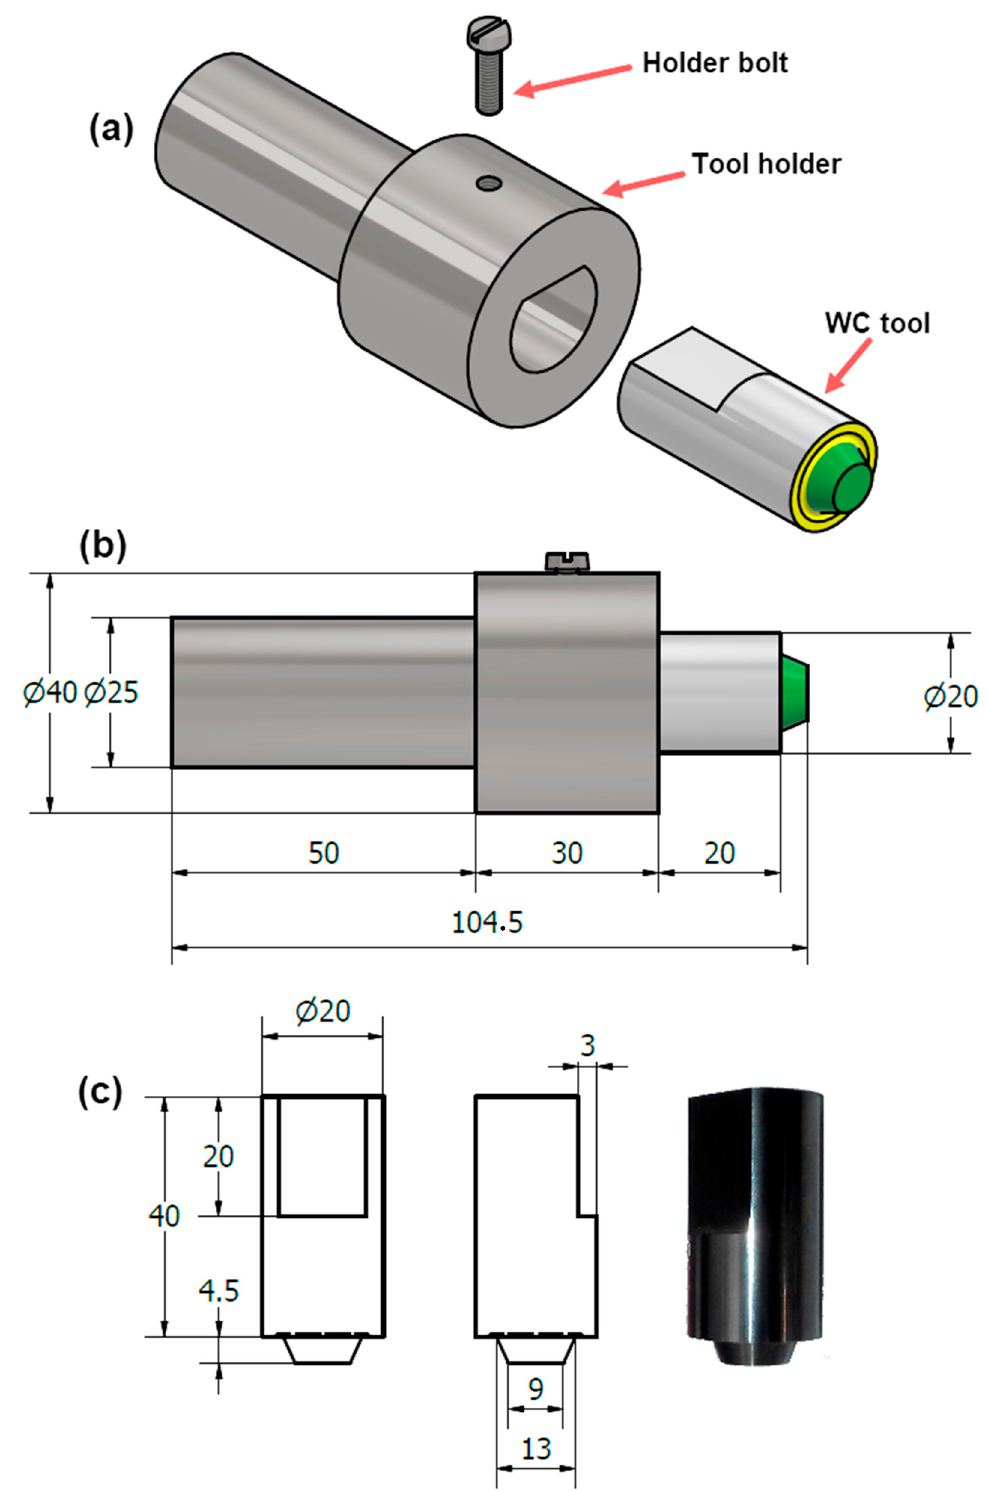
Figure 2. ( a ) Exploded drawing FSW tool parts ( b ) dimension of FSW tool ( c ) real view and dimen- sions of WC tool geometry.(unit: mm) A visual test and macro examination of the welded joints were carried out to discover the welding defects on the weld surfaces and across 2205 DSS butt welded joints. Macro and metallographic specimens were cut perpendicular to the path FSW direction and ground with SiC abrasive papers up 2400 grit, followed by polishing to 0.05% alumina